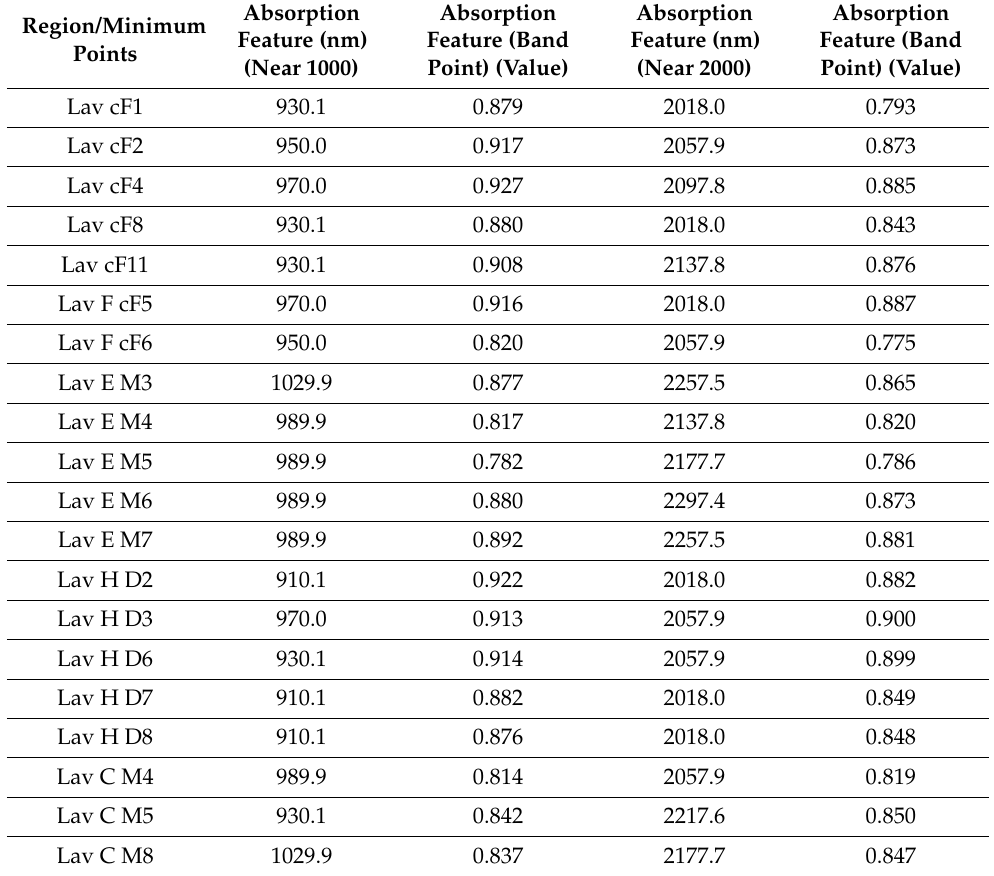
Table A4. The minimum point values (abbreviations for each terrain *) for each crater in Figure